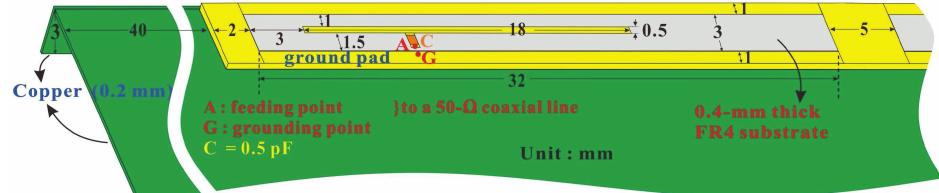
Figure 2. Detailed structure of a single 5G antenna (Ant